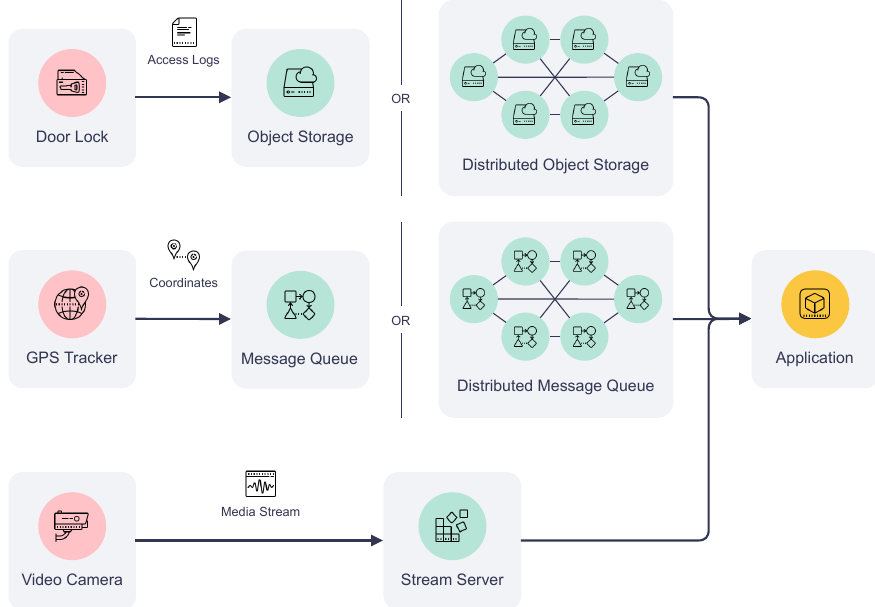
Figure 5. Auxiliary storage types and